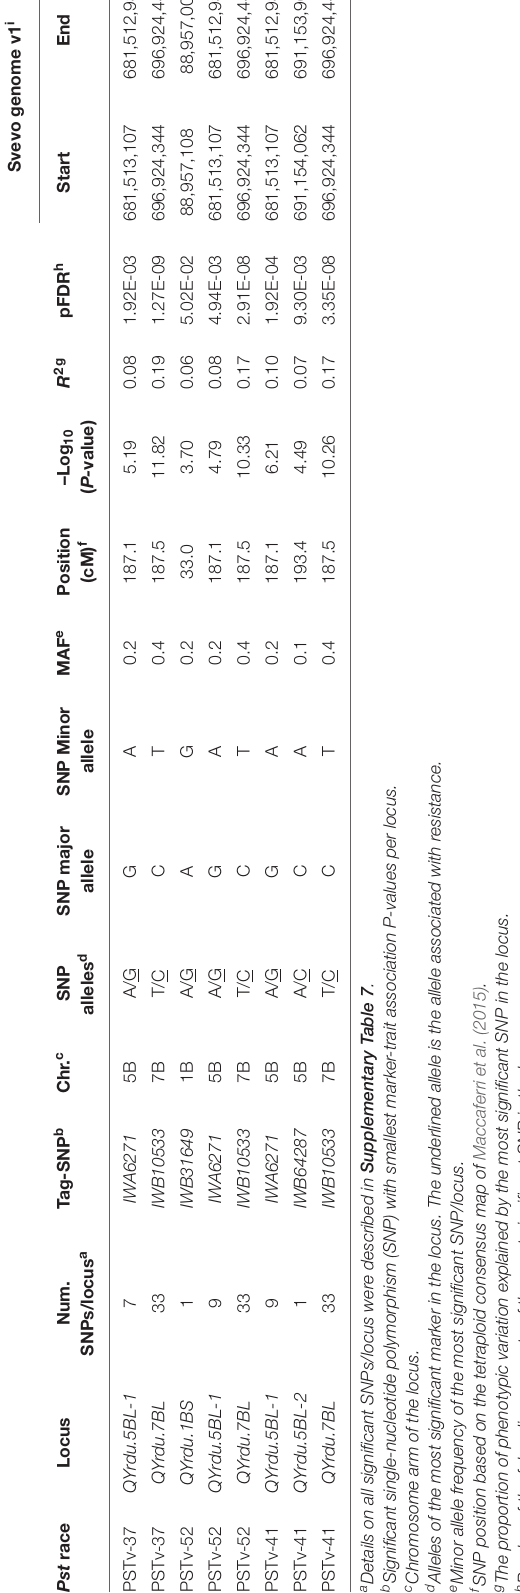
A total of 61% of the durum genotypes carry an Sr13 allele and Sr8155B1 , whereas 50% of the durum collection carry an Sr13 allele and Sr7b. We found that 54% of the durum genotypes have a least Sr8155B1 and Sr7b and 40% of the genotypes have the three genes Sr13 , Sr8155B1 , and Sr7b. Based on Sr13 allele markers, Sr13 functional alleles Sr13a-R1 , Sr13b , and Sr13a-R3 were identified in the durum genotypes. Sr13b was the most common allele, being present in 56% of the durum genotypes. Sr13a-R1 and Sr13a-R3 were less frequent and occurred in only 17 and 7% 2019 ) . of the durum accessions, respectively ( Supplementary Table 9 ). Because gene postulation for these three genes was possible based only on the phenotype, we determined the accuracies of markers dCAPS_Sr13 , IWB69393 , KASP_6AS_IWB10558, and IWA4651 . For the gene Sr13 , the accuracy for dCAPS_Sr13 and IWB69393 was 100 and 95% (3% false positives and 2% false negatives), respectively. For Sr8155B 1, the marker KASP_6AS_IWB10558 had an accuracy of 99.6% (0.4% false positives), whereas for Sr7b , the marker IWA4651 had an accuracy of 98.8% (1.2% false positives). The postulation of the remaining three large-effect Sr loci in each genotype ( Supplementary 3 ) showed that